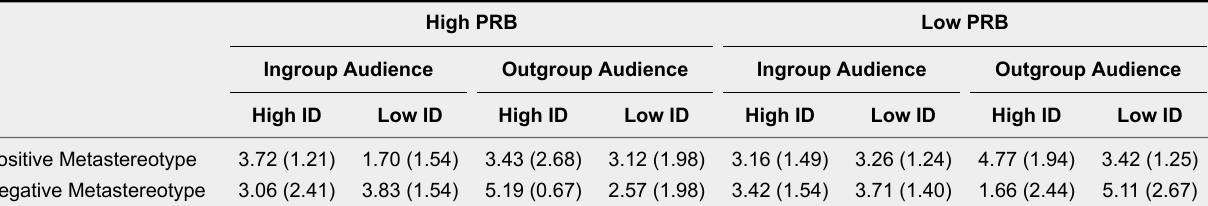
Intention to Help the Outgroup as a Function of Metastereotype Condition, Ingroup Identification, Audience Group Membership, and Perceived Reputational